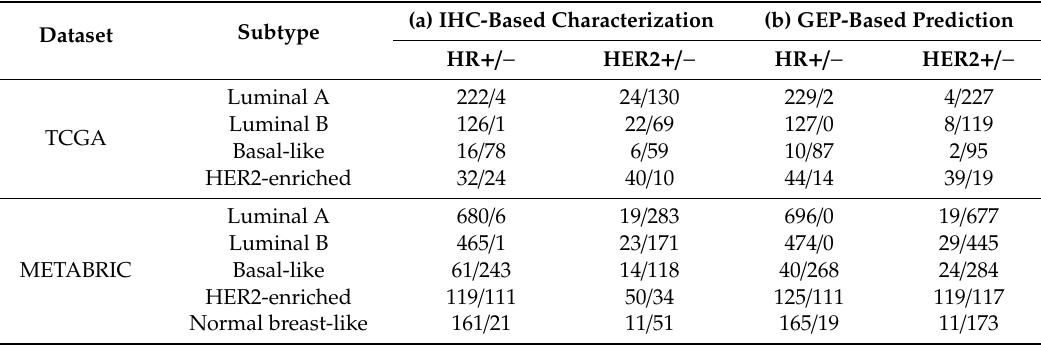
Table 2. HR and HER2 status for each intrinsic subtype as determined by (a) IHC- and (b) GEP-based prediction. Patients with no available IHC-based receptor status were